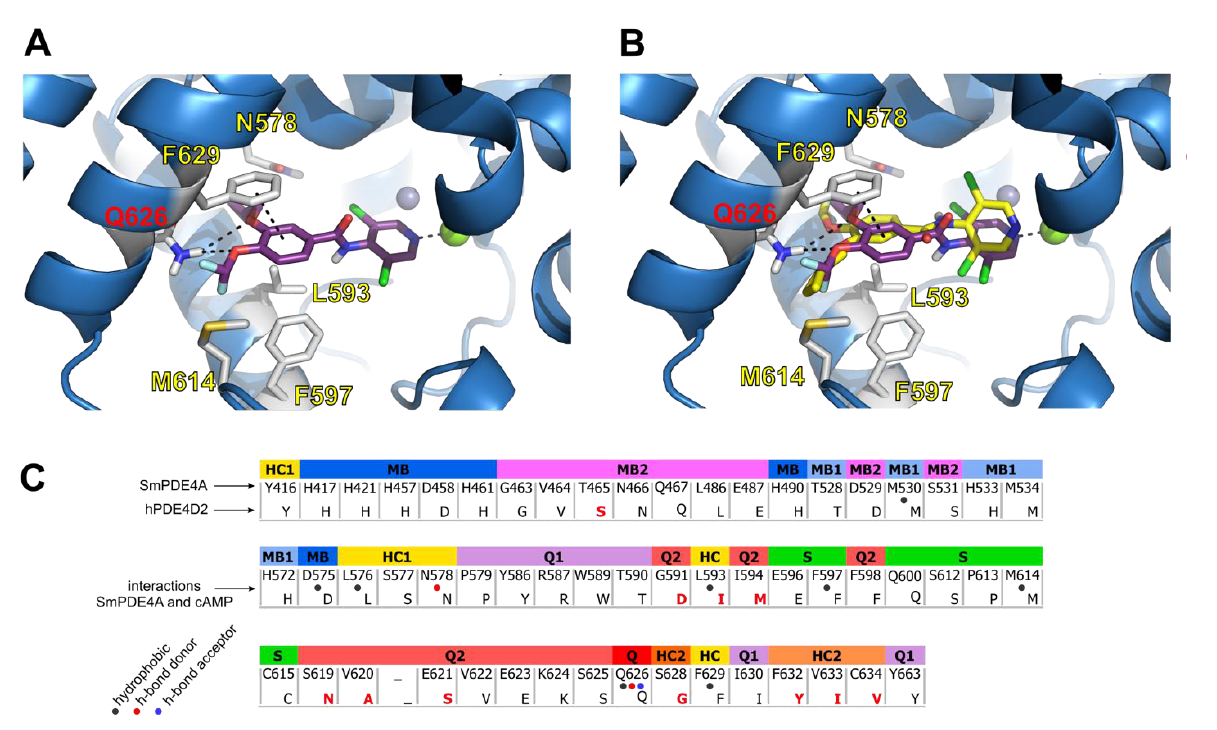
Figure 5. Docking results of roflumilast in SmPDE4A and comparison with the docking in hPDE4D2. ( A ) The docking pose of roflumilast in the catalytic site of SmPDE4A. The residue nomenclature follows the PDEStrIAn database [35]. ( B ) The docking pose of roflumilast in SmPDE4A (purple) and reference roflumilast (yellow) in hPDE4D (PDB:1XOQ). The docking pose makes hydrogen bonds with Q626 (Q Q.50 ) and face-to-face π-stacking interaction with F629 (F HC.52 ) as roflumilast in hPDE4D (PDB:1XOQ). ( C ) Alignment of the binding site residues of the SmPDE4A and hPDE4D2. The color bar above the residues indicates their location in the binding site. The different residues are highlighted in red. The interactions between SmPDE4A and cAMP are shown with dotted points with hydrophobic colored in grey, hydrogen bond donor colored in red and hydrogen bond acceptor colored in blue.